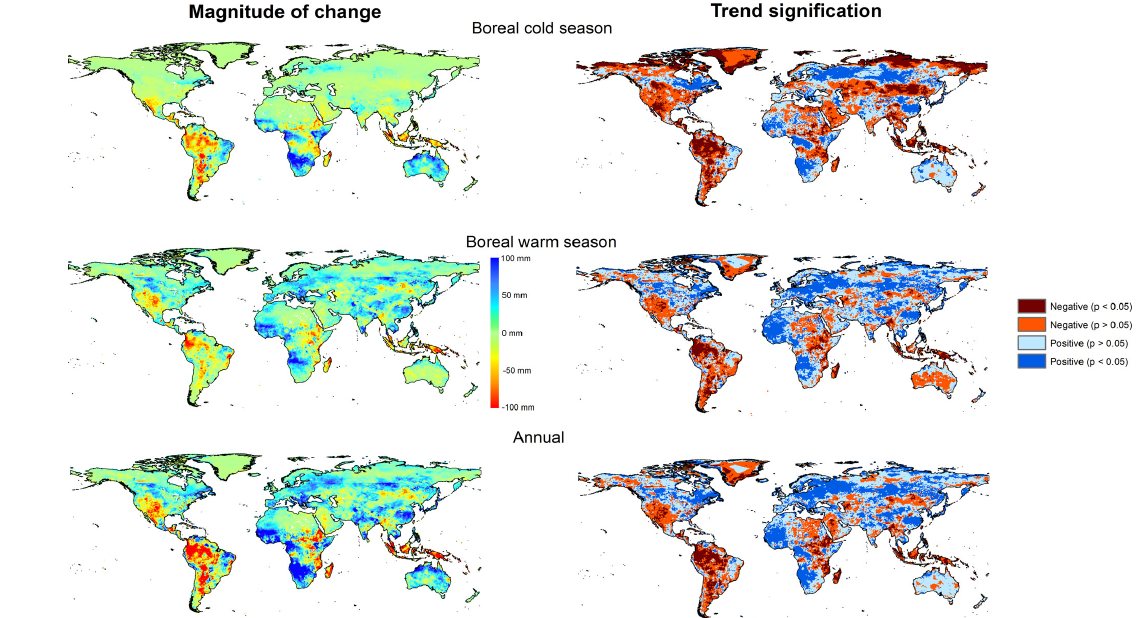
Figure 12. Spatial distribution of the magnitude of change in the annual and seasonal land evapotranspiration (1979–2014) and their corre- sponding statistical